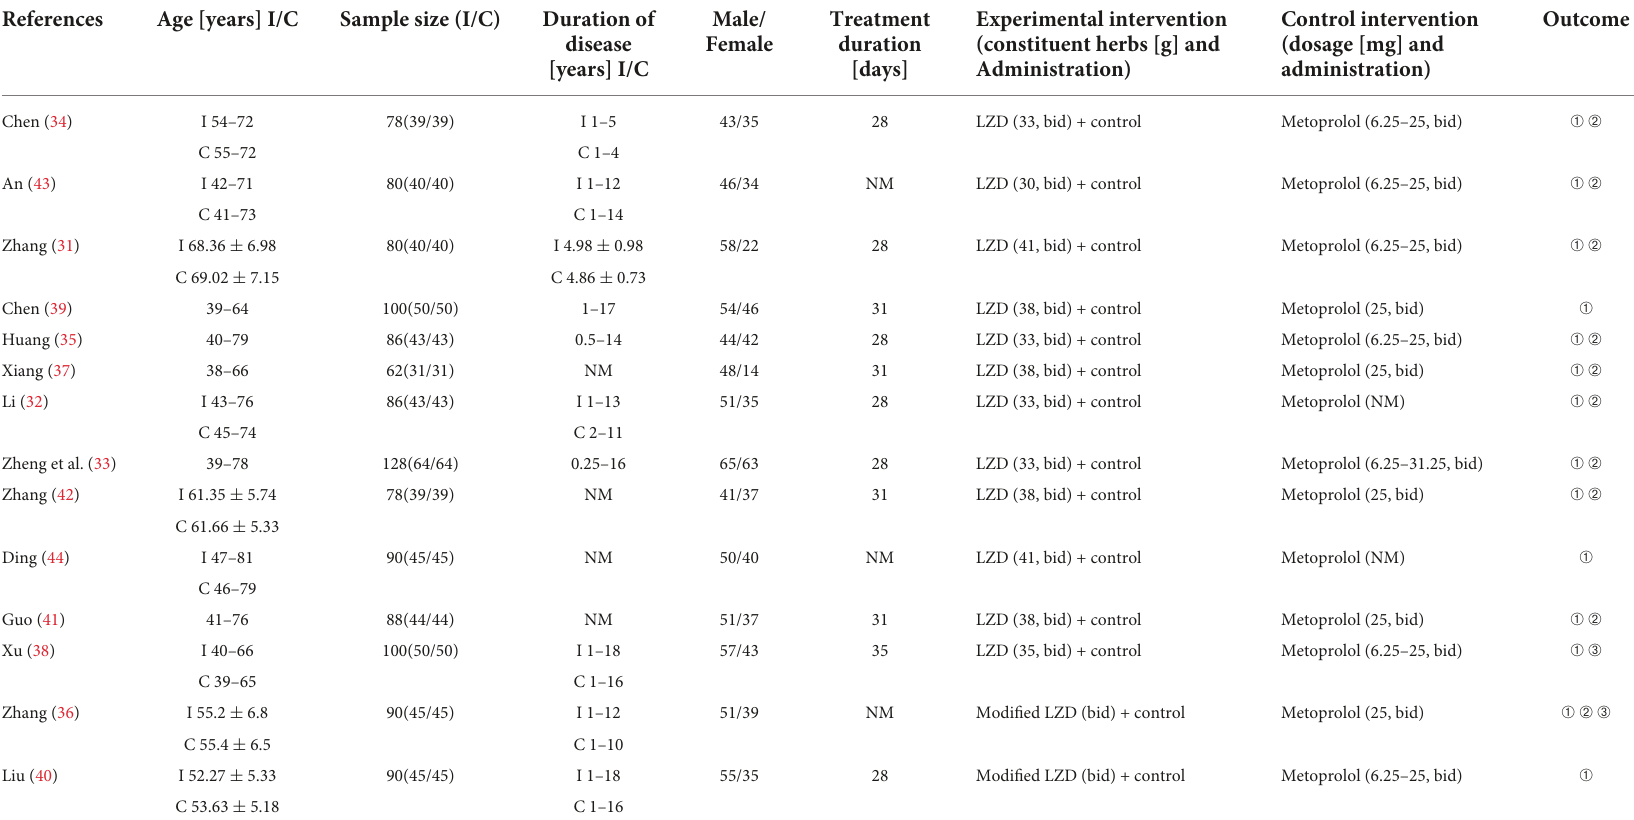
TABLE 2 Summary of the characteristics in each included